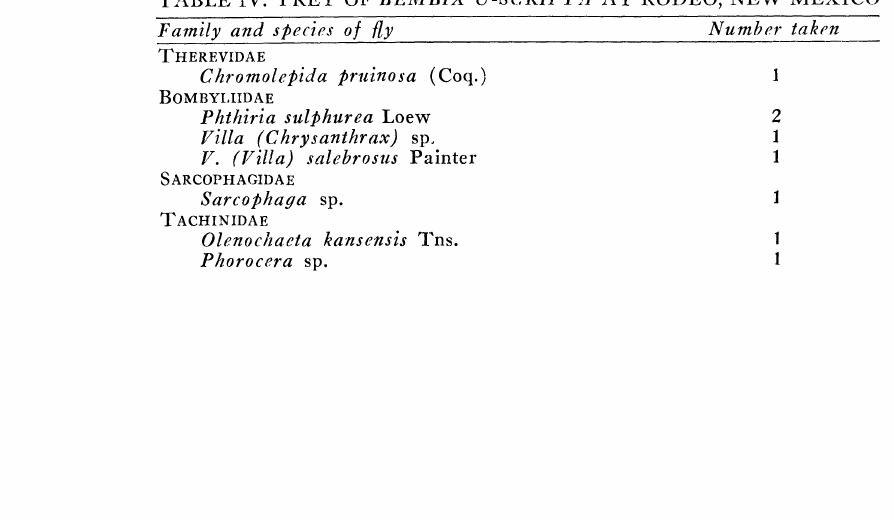
TABLE IV. PREY OF BEMBIX U-SCRIPTA AT RODEO, NEW MEXICO Family and species of [ly Number taken THEREVIDAE Chromolepida pruinosa (Coq.) BOMBYLIIDAE Phthiria sulphurea